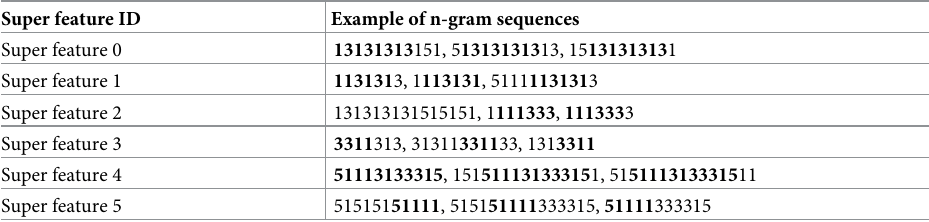
Table 4. Example of CMD super features. The bold text represents the repetitive patterns within each